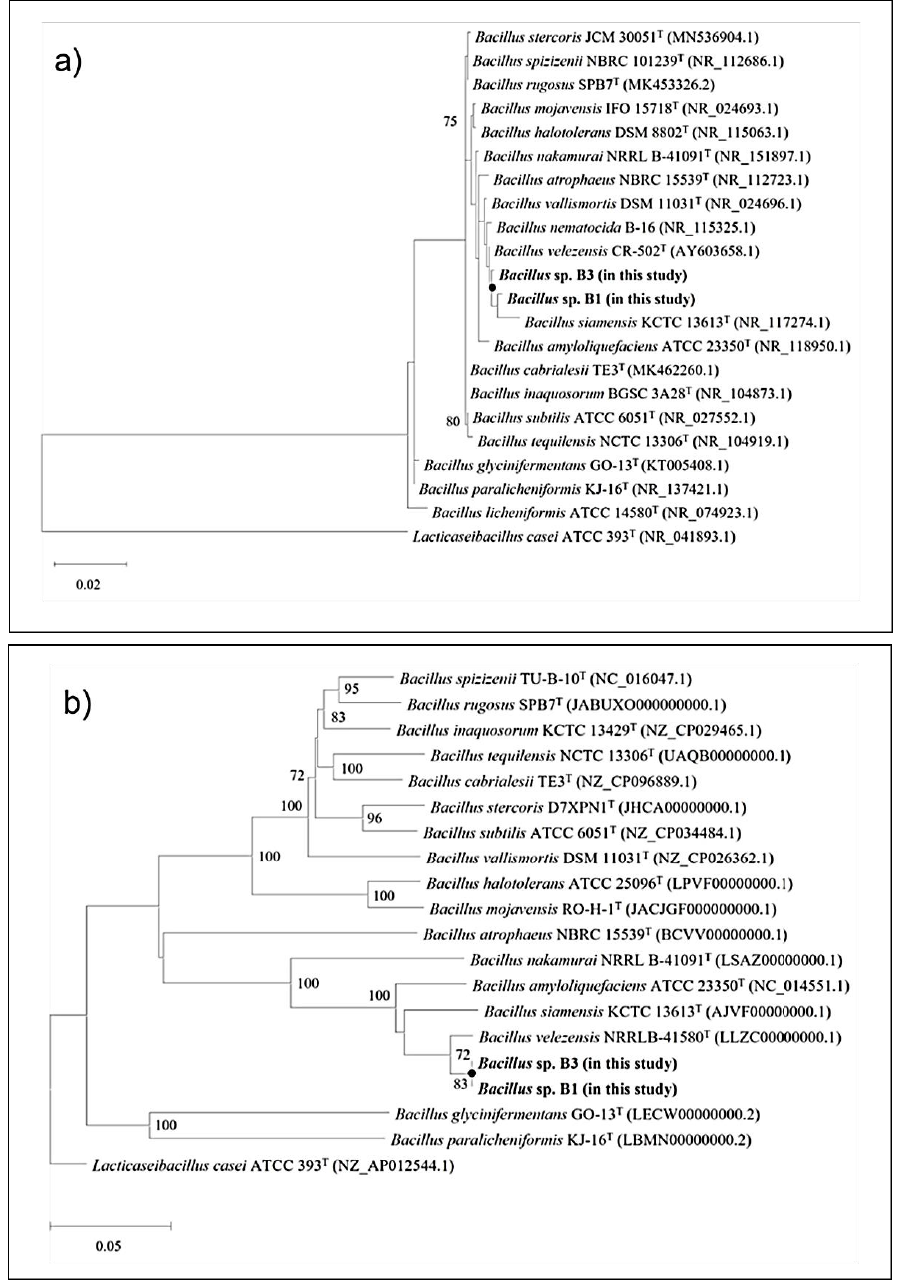
Figure 2. Phylogenetic tree based on the 16S rRNA gene sequences ( a ) and whole-genome sequences ( b ) detailing the relationships of Bacillus isolates B1 and B3 with 20 type strains of Bacillus spp. and the outgroup Lactobacillus casei ATCC 393 T . The bootstrapping values are indicated at the branches using 1000 and 100 replicates, and only bootstrap values >70 are presented. The scale bar represents 0.02 or 0.05 nucleotide substitutions per site. Table 6. The secondary metabolite gene clusters in the isolate B1 obtained using anti-SMASH. Position Region Biosynthetic Gene Clusters Substance Similarity (%) from to